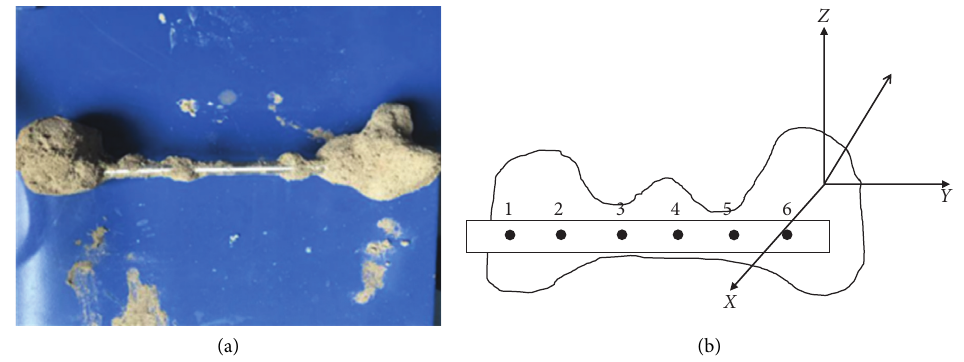
Figure 6: (a)The hardened grout mass and (b) its cross section.